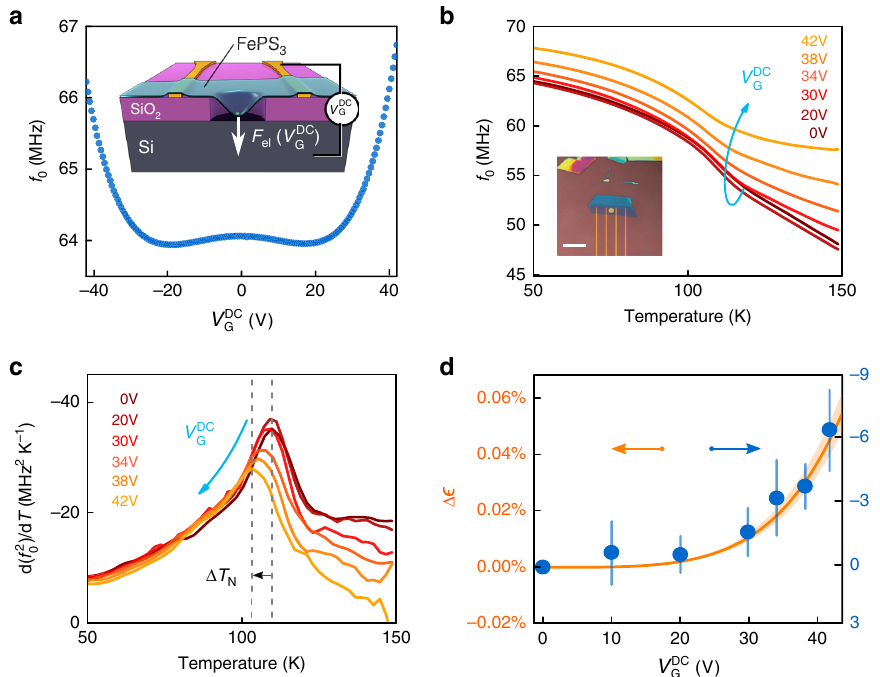
Fig. 3 Resonance frequency and transition temperature tuning with a gate voltage. a Resonance frequency as a function of gate voltage at 50 K. Inset: schematics of the electrostatic tuning principle. b Resonance frequency as a function of temperature for six different voltages. Inset: optical image of the sample, t = 8 ± 0.5 nm. Scale bar: 16 μ m. c Derivative of f 2 as a function of gate voltage and temperature. Blue arrow, line colors and legend indicate the 0 ¼ T (cid:6) ð V DC Þ (cid:2) T ð 0 V Þ with increasing V DC values of V DC . Dashed gray lines indicate the decrease in transition temperature Δ T . d Blue solid dots — shift in N N G N G G T V DC extracted from the peak position in ( c ). Vertical blue bars — error bar in Δ T N estimated from determining the peak position in ( c ) N as a function of G within 2% accuracy in the measured maximum. Orange solid line — model of electrostatically induced strain Δϵ as a function of V DC (see Supplementary G Note